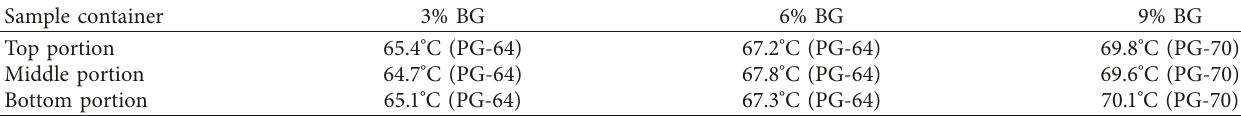
Table 4: Performance grades showing homogeneous